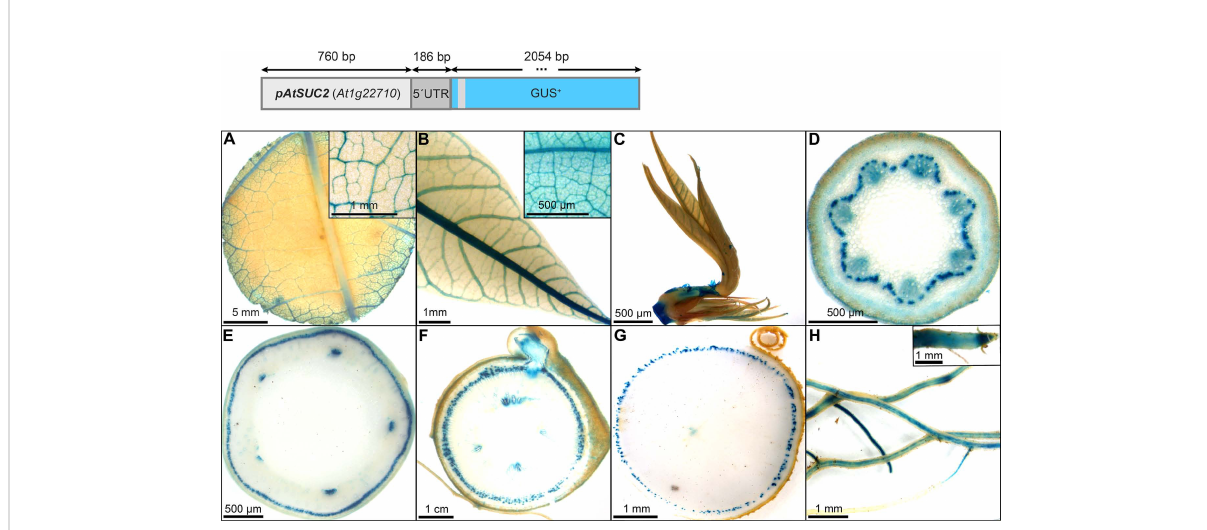
FIGURE 4 Representative GUS staining pattern of four pAtSUC2::GUS promoter-reporter lines. (A) Source leaf (Inlay = Close-up), (B) Sink leaf (Inlay = Close-up), C Emerging leaves, (D) Petiole cross-section, (E) Upper stem cross-section, (F) Lower stem cross-section, ( G ) Storage root cross- section, (H) Fibrous roots (Inlay = Root